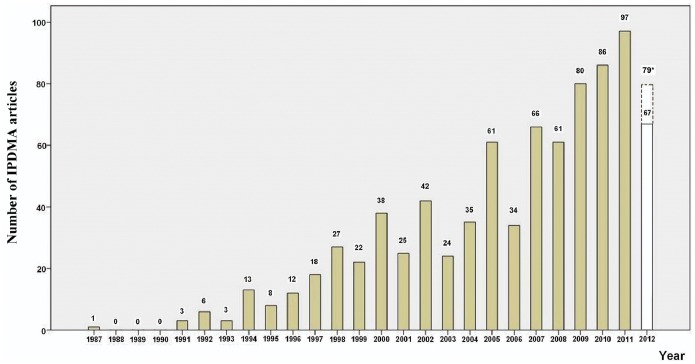
Numbers of IPDMAs published by year up to August 9, 2012.*Expected total numbers of IPDMAs published in 2012.